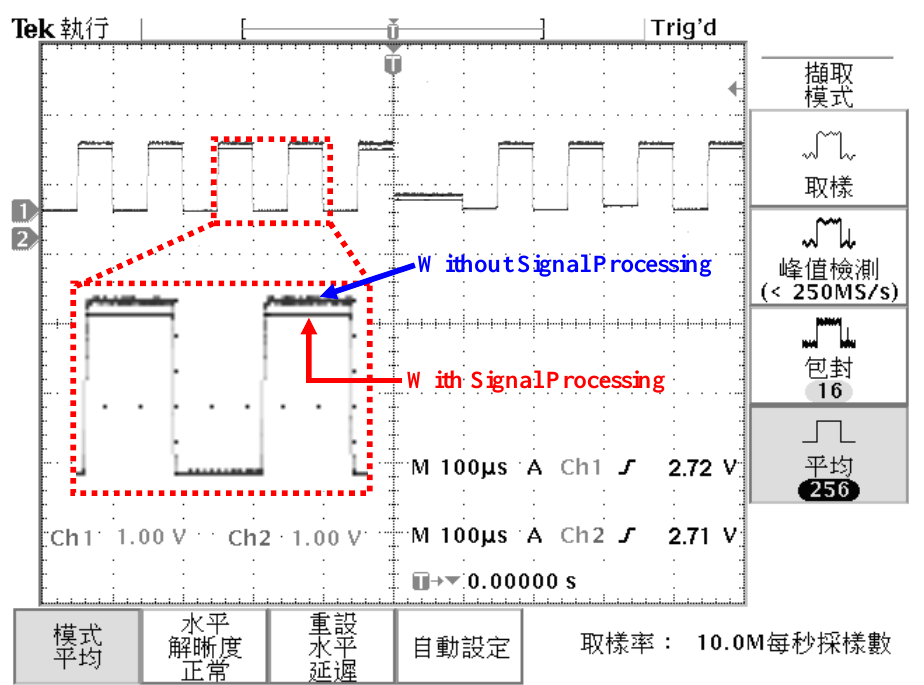
Figure 25. Experimental results using signal